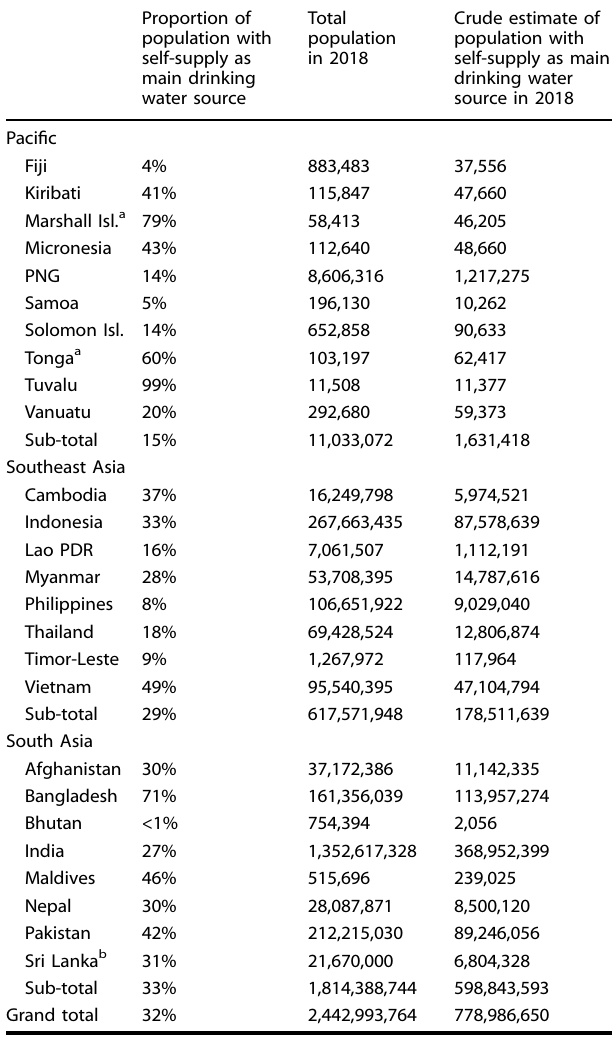
Table 1. Crude estimates for population using self-supply as a main drinking water source in 2018 (based on most recent